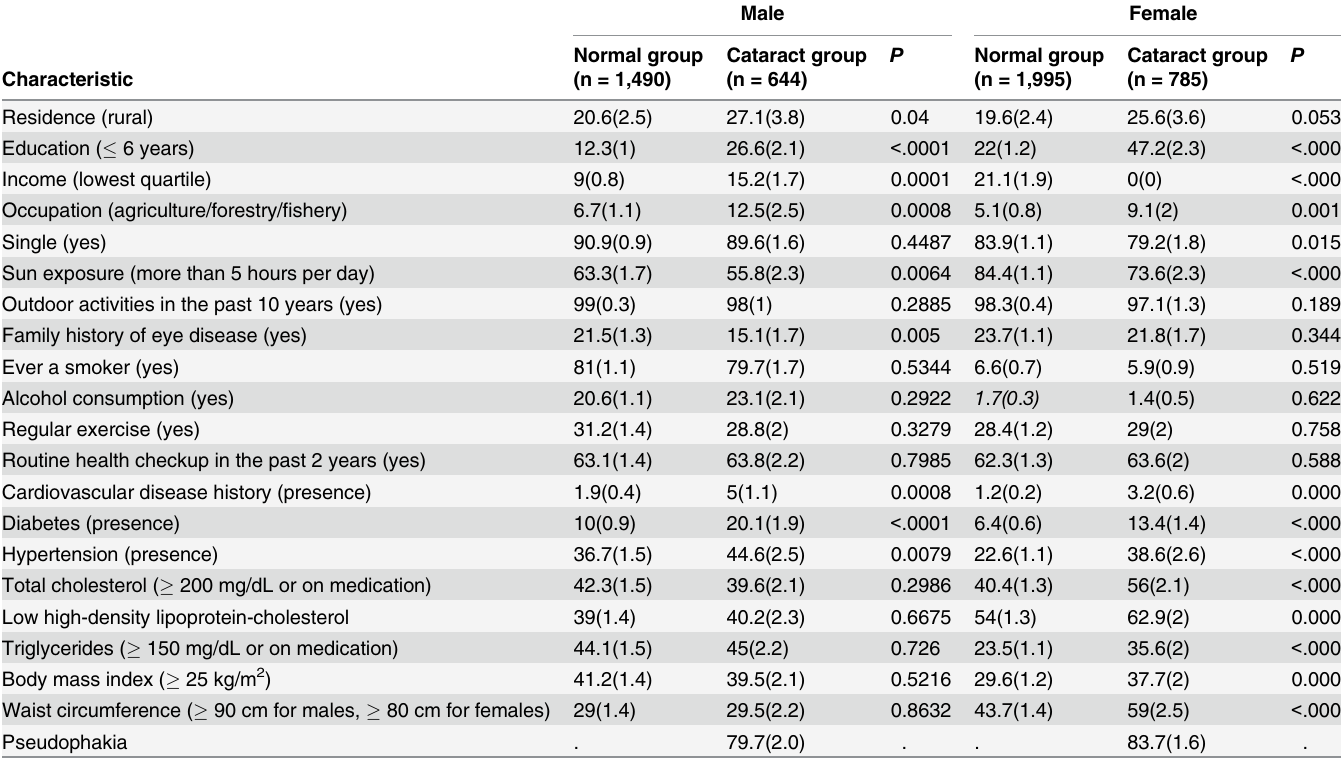
Table 2. Univariate analsysis comparing between middle-aged men and women according to the presence of cataracts according to